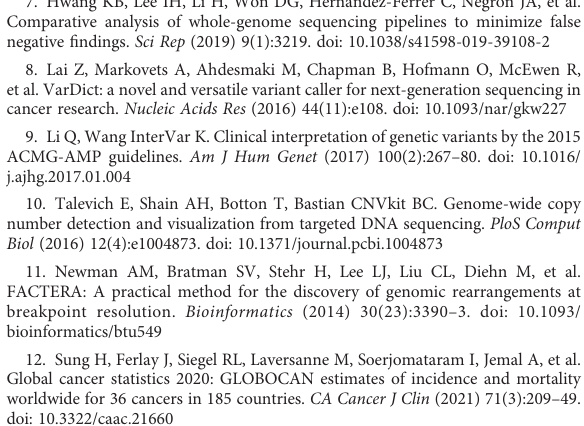
SUPPLEMENTARY FIGURE 1 CPE and ALK expression level in LUAD and LUSC. A.CPE expression in LUAD and LUSC, T for tumor(red), N for normal(gray); B. EML4 expression in LUAD and LUSC, T for tumor(red), N for normal(gray) SUPPLEMENTARY FIGURE 2 Exon 6 information in CPE (A) and exon 20 information in ALK (B) ; Schematic of CPE-ALK may cause the ALK gene to be out of frame (C)